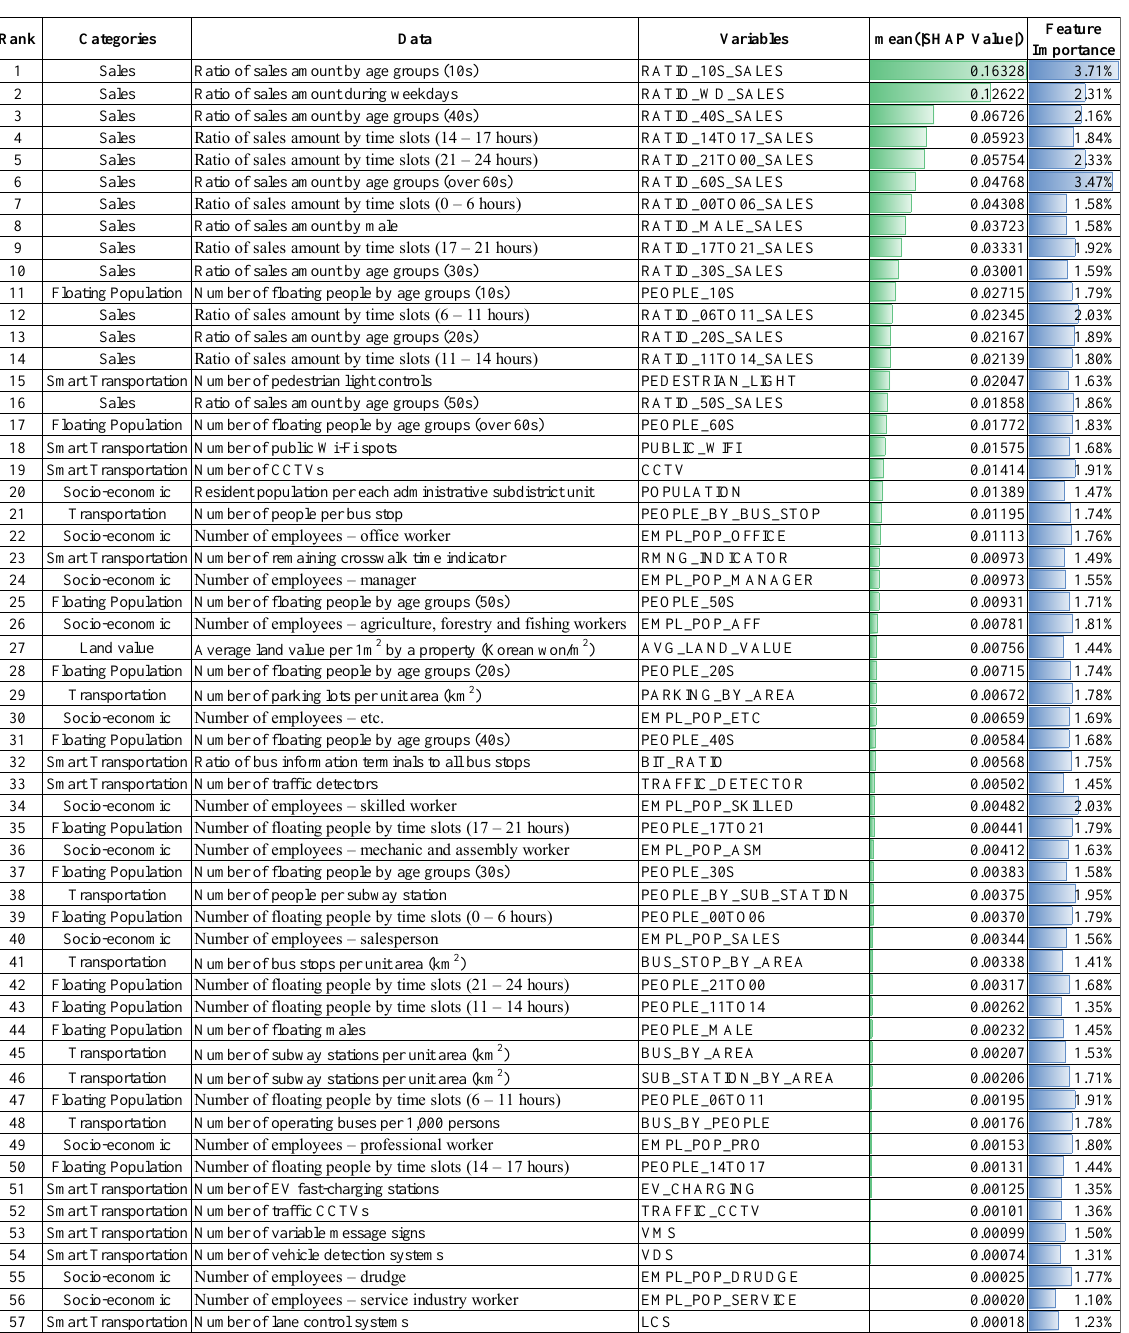
Figure 4. All features in order by mean absolute SHAP values.